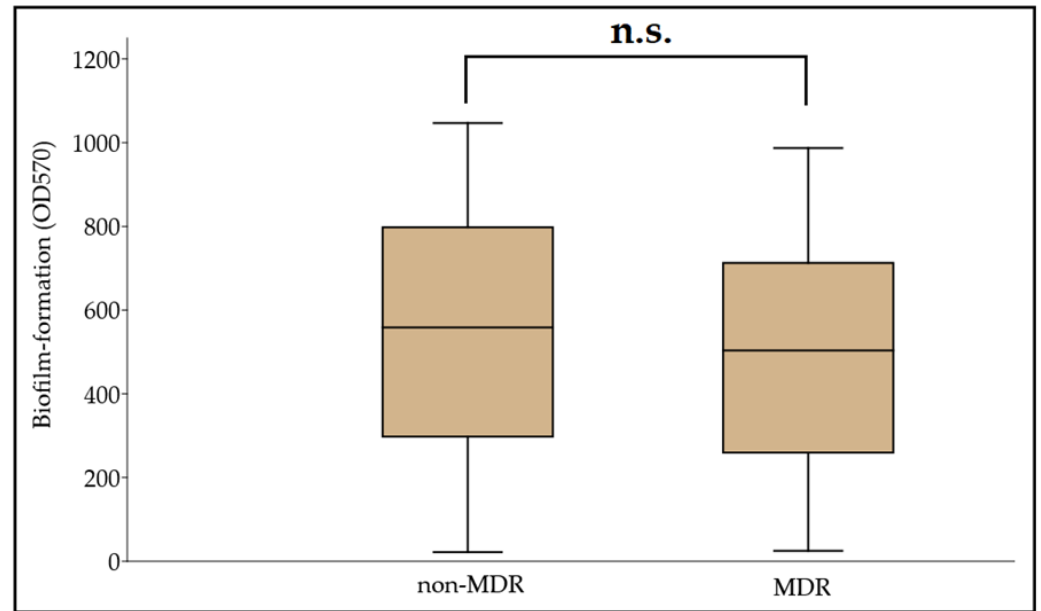
Figure 1. Comparison of biofilm-forming capacity among non-MDR and MDR A. baumannii isolates; n.s.: not significant ( p = 0.072).